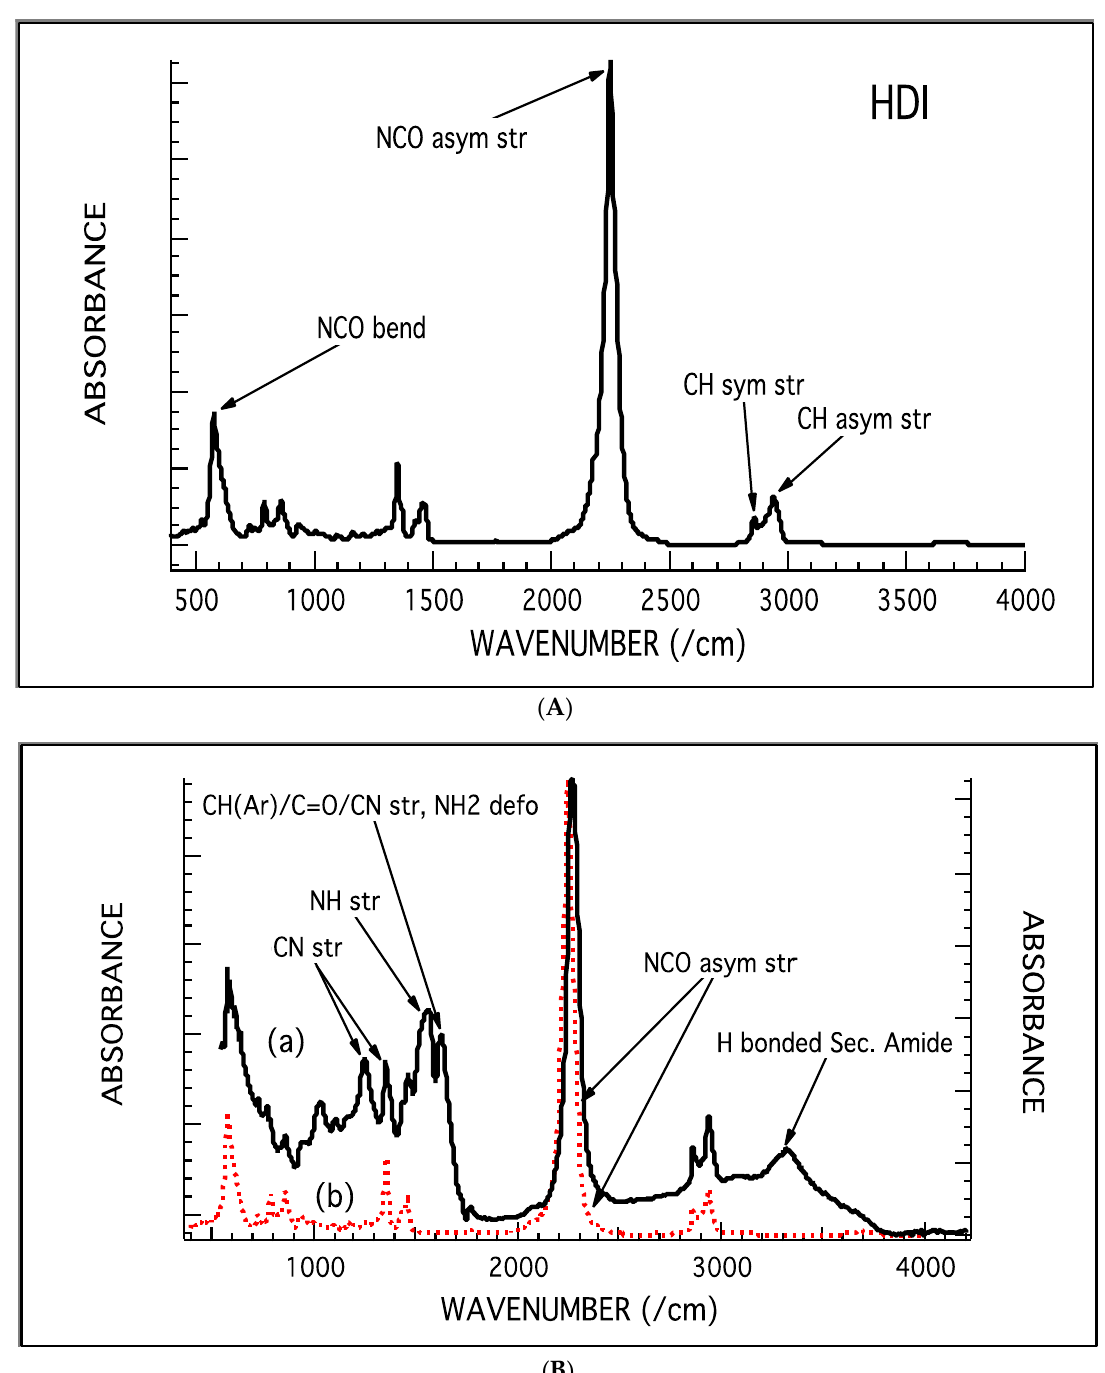
Figure 1. ( A ) FTIR of HDI. ( B ) FTIR of microcapsules with 22% free formaldehyde shell:core ratio 1:2 and water:oil ratio of 5.5:1. FTIR of: (a) Microcapsules with a water-to-oil ratio of 5.5:1; (b)